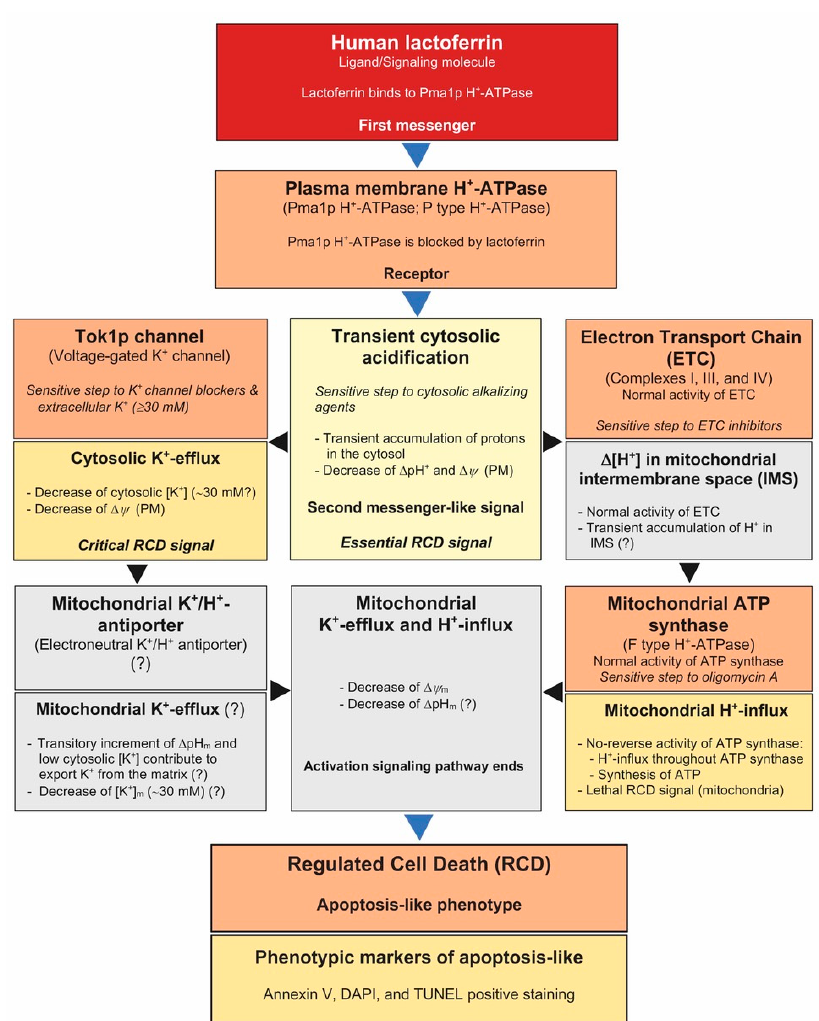
Figure 5. Proposed model of the RCD signaling pathway induced by lactoferrin. The scheme includes hypothetical steps (gray boxes) of this process based on our previously reported data [2,4,32,34]. In yeast cells, Pma1p H + -ATPase actively extrudes H + out the cell and generates a proton gradient ( ∆ pH) and an electrical gradient ( ∆Ψ ) which allow pH regulation and the flux of other ions and nutrients